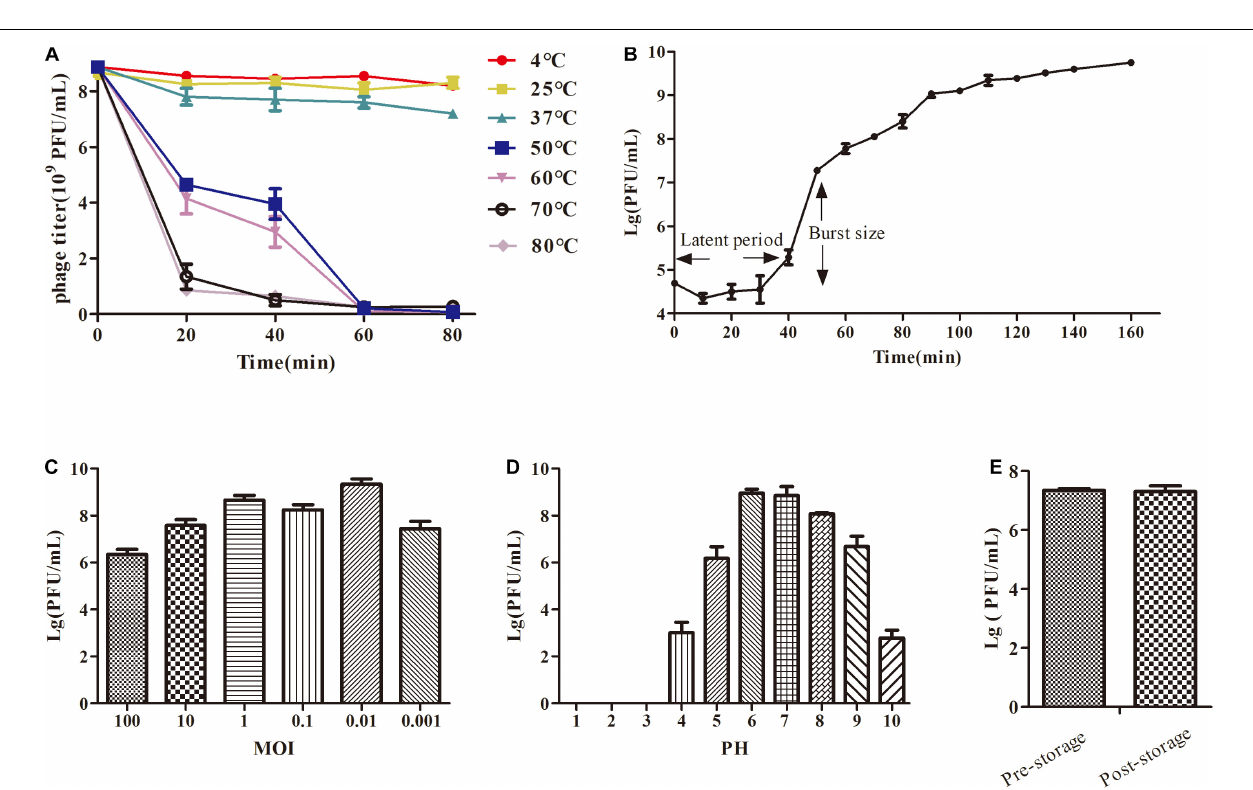
FIGURE 2 | The growth characteristics and stability tests of IME-JL8. (A) Thermal stability: phage particles were incubated at different temperatures as indicated. (B) A one-step growth curve of IME-JL8. (C) Titers of the phage under different MOI (phage/bacteria = 0.001, 0.01, 0.1, 1, 10, and 100), as represented in the Y -axis. At the MOI of 0. 01, IME-JL8 peaked the maximum titers. (D) pH stability: IME-JL8 were incubated under different pH values. (E) Long-term storage stability: the titer of pre-storage and post-storage (for 1 year) of